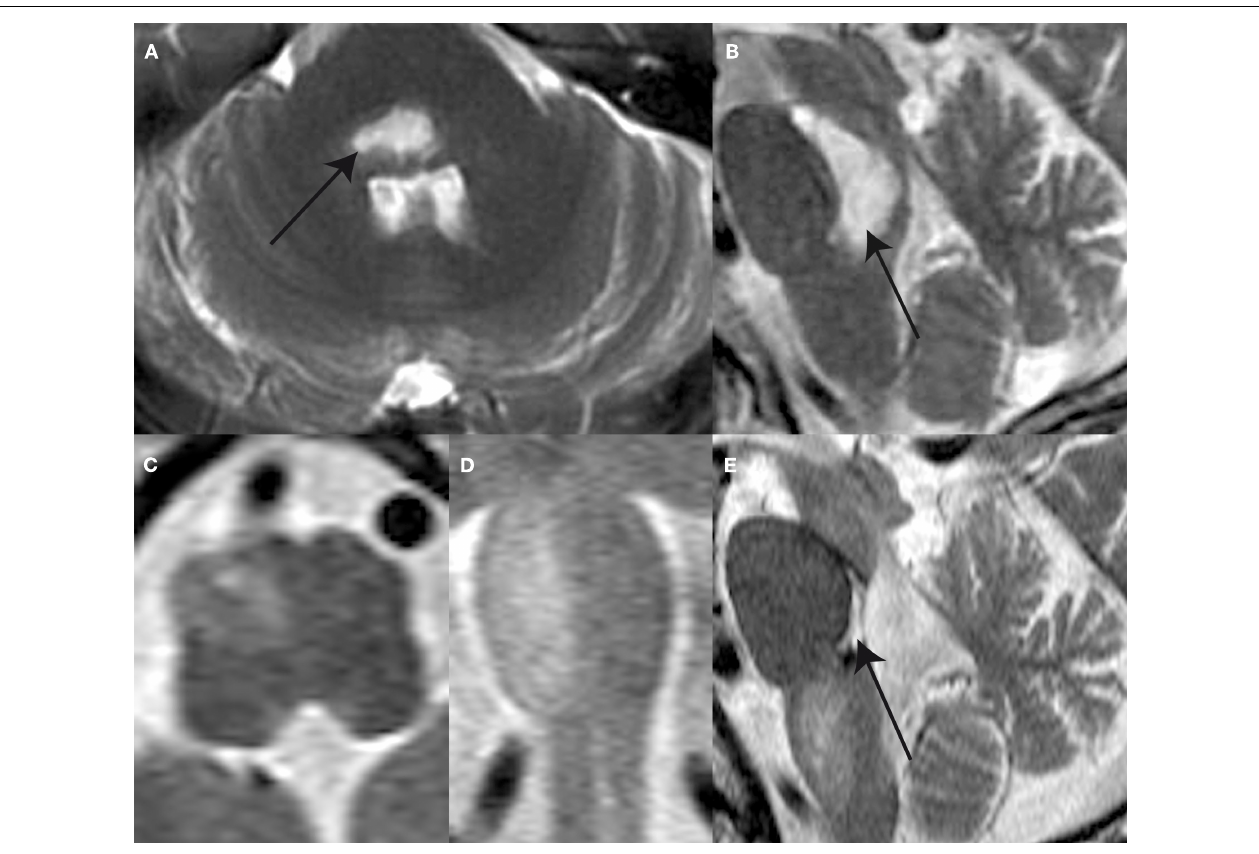
after 4months reveals hypertrophy and prominence of the right ION as illustrated in the axial (C) , coronal (D) , and sagittal (E) plane images. Note the defect within pontine tegmentum (arrow) following resorption of